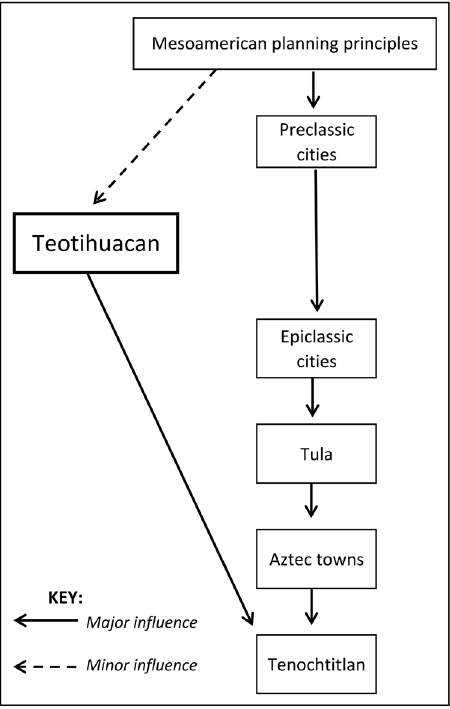
Figure 1. Historical trajectory of urban planning in central Mexico. Graphic by